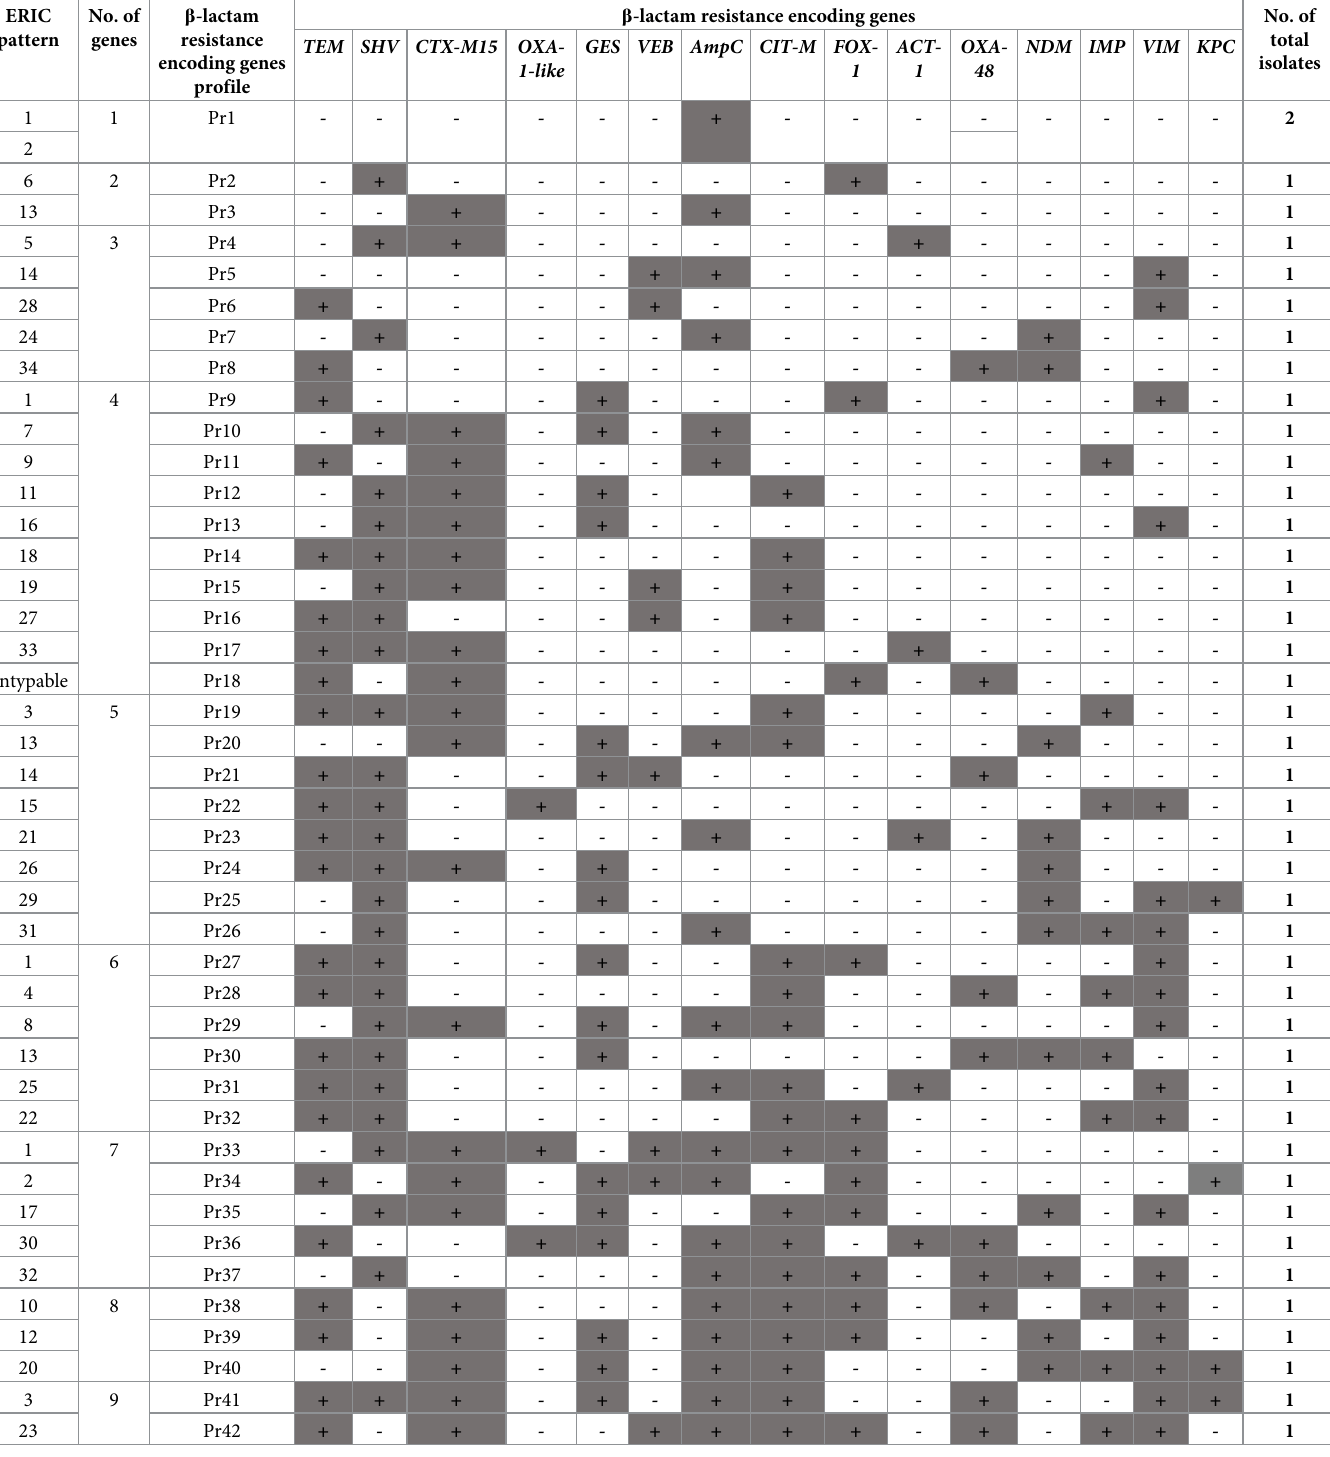
Table 4. Relationship between ERIC typing and β -lactam resistance encoding genes